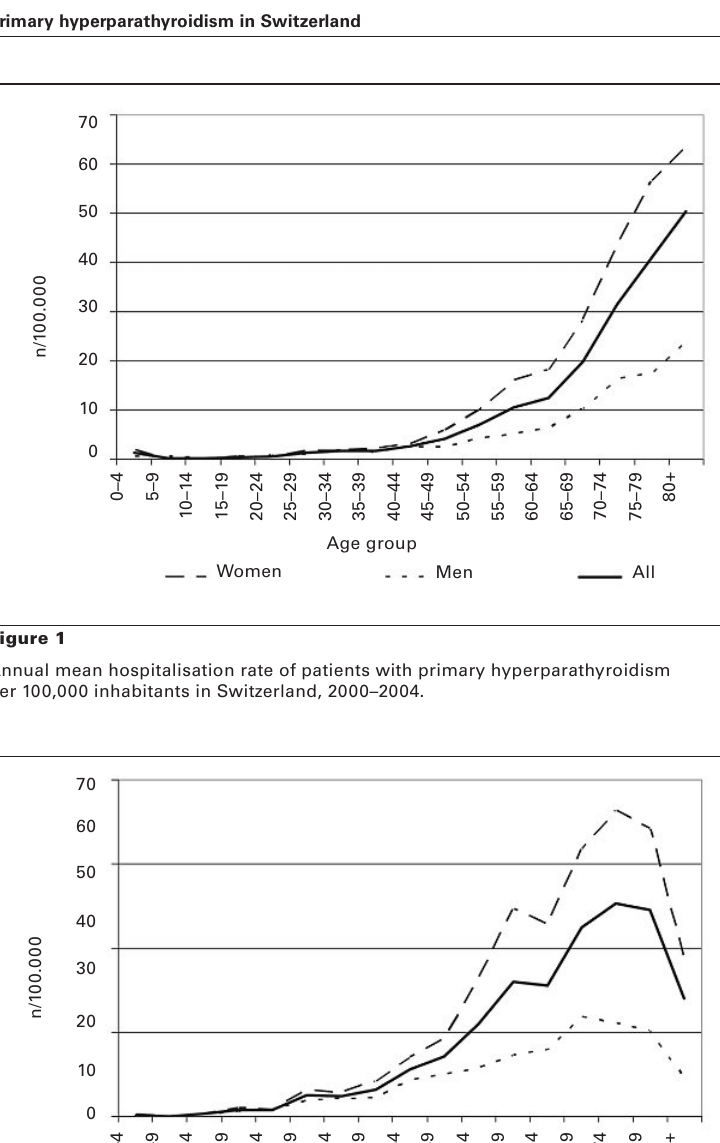
<50 years (1.9/100,000 vs 1.2/100,000, respec-